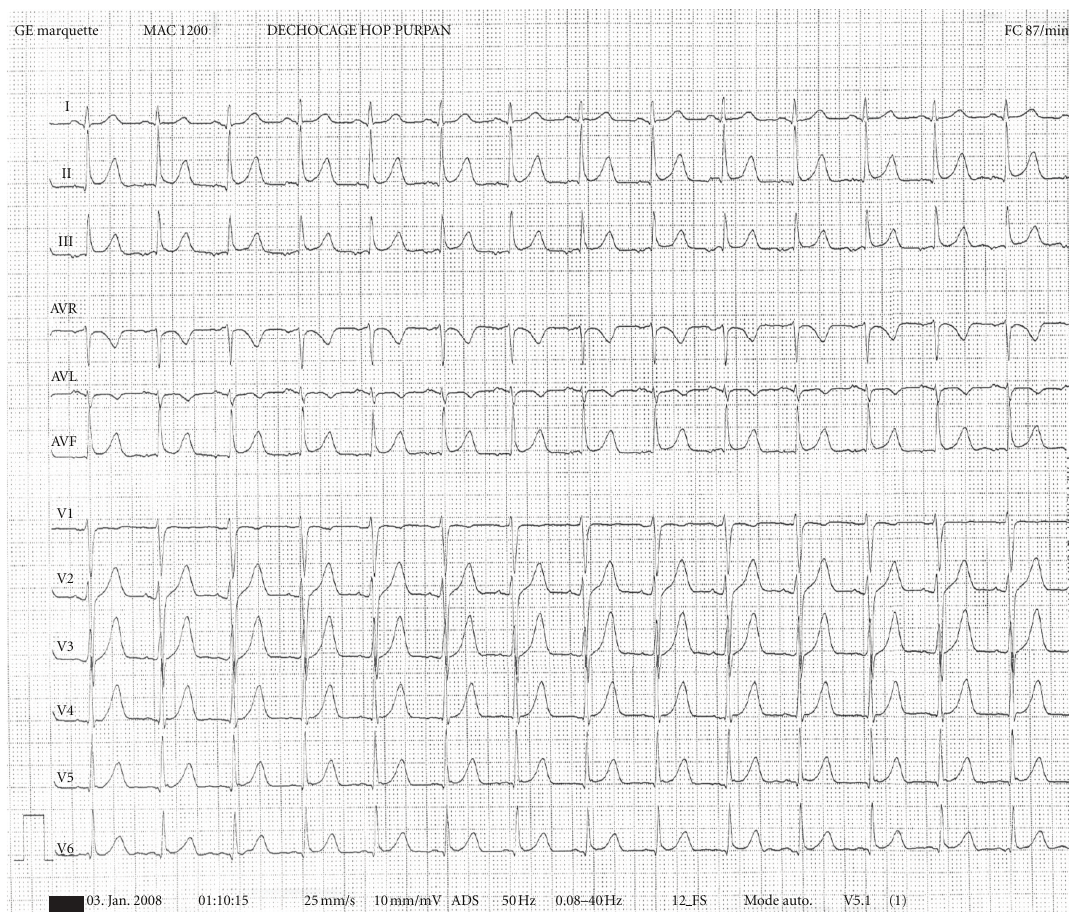
Figure 1: ECG shows sinus, regular rhythm, normal axis, and fine QRS, but there was a broad and sharp T wave.